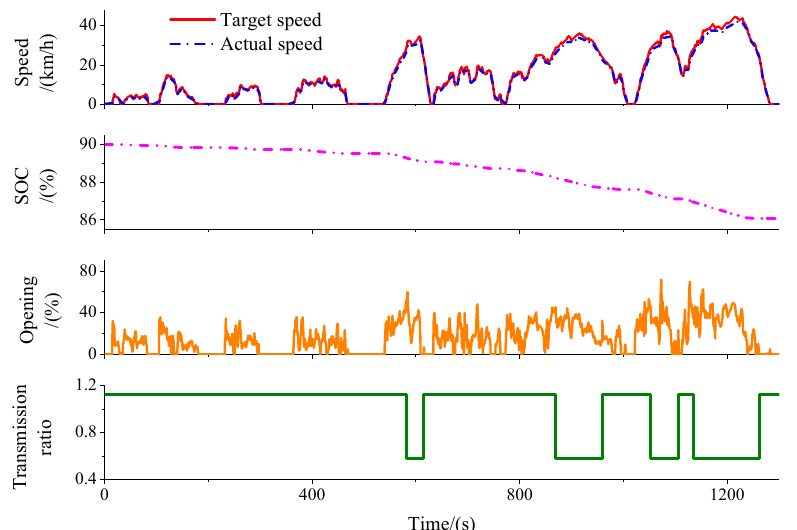
Figure 24. The simulation results of the energy consumption of the optimal power shift rule.